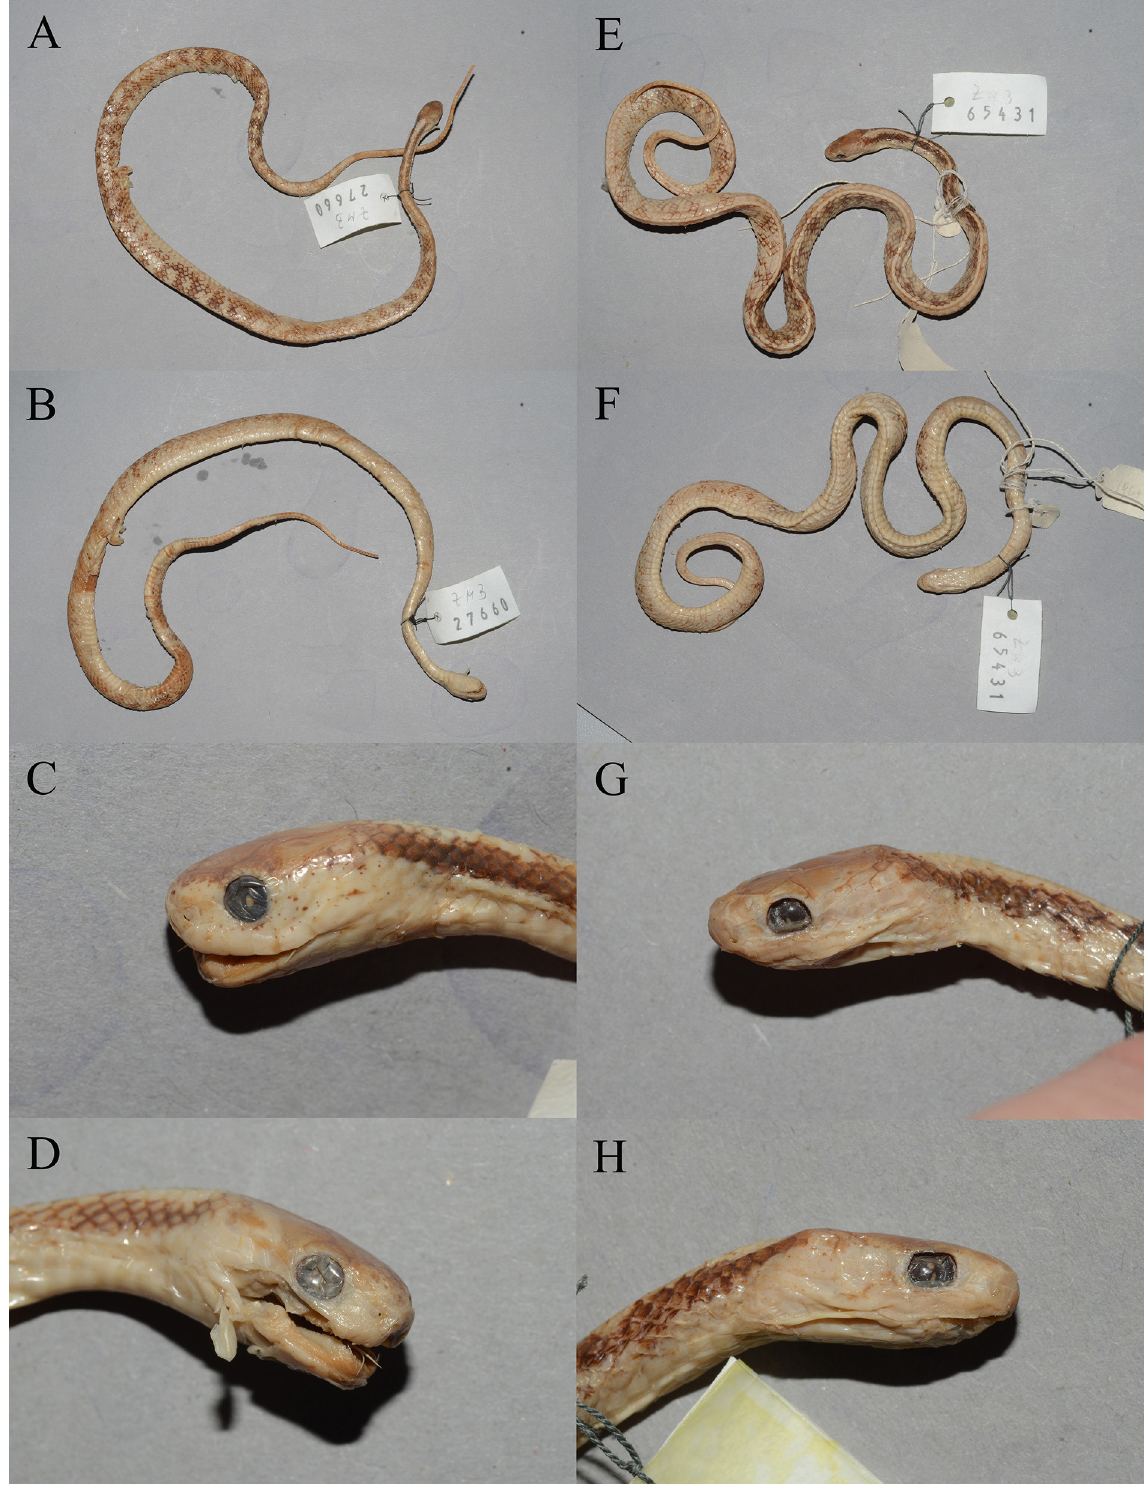
Fig. 2. Pareas yunnanensis (Vogt, 1922), syntypes in preservative. A–D . ZMB 27660. A . Dorsal view. B . Ventral view. C–D . Close up views of the head. E–H . ZMB 65431. E . Dorsal view. F . Ventral view. G–H . Close up views of the head. Photos by G.